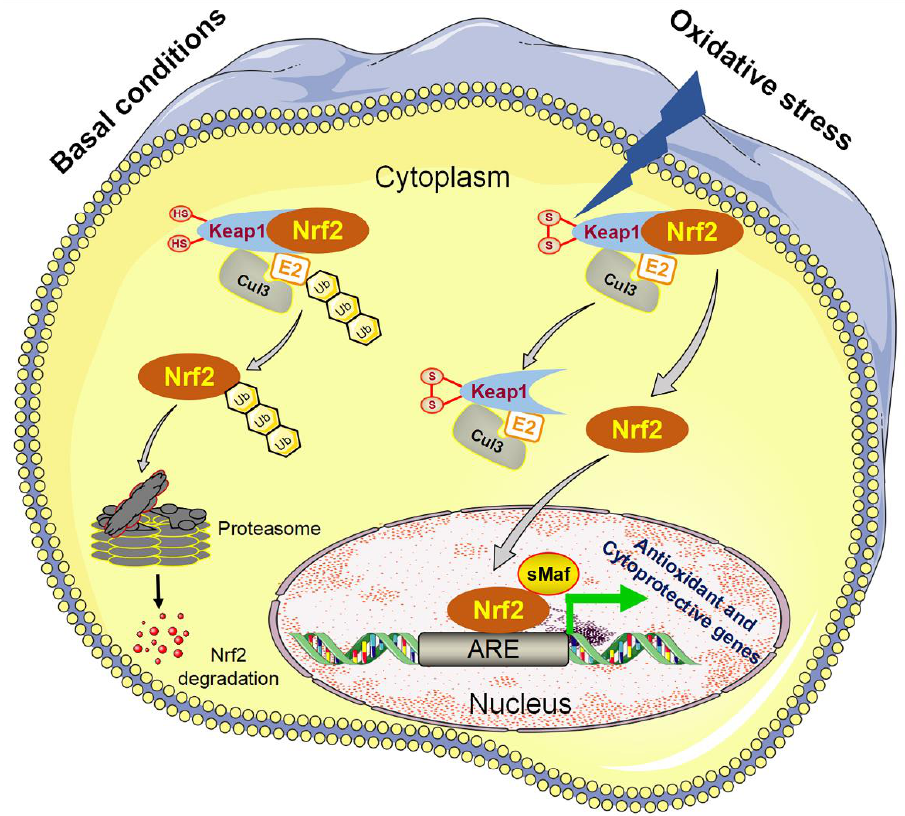
Figure 1. Schematic diagram of Keap1-Nrf2-ARE signaling pathway. Under basal non-stressed conditions, Keap1 binds to cullin 3 (Cul3)-based E3 ubiquitin ligases, forming Keap1-Cul3-Nrf2 complex, leading to Nrf2 ubiquitination and proteasomal degradation. In response to oxidative stress, some cysteine residues of Keap1 are oxidized, resulting in a conformation change in Keap1 and disruption of the Keap1 – Cul3 interaction. Nrf2 then dissociates from Keap1 and translocates to the nucleus, where it forms a heterodimer with small Maf proteins (sMaf), binds to ARE and stimulates the transcription of antioxidant and cytoprotective genes.